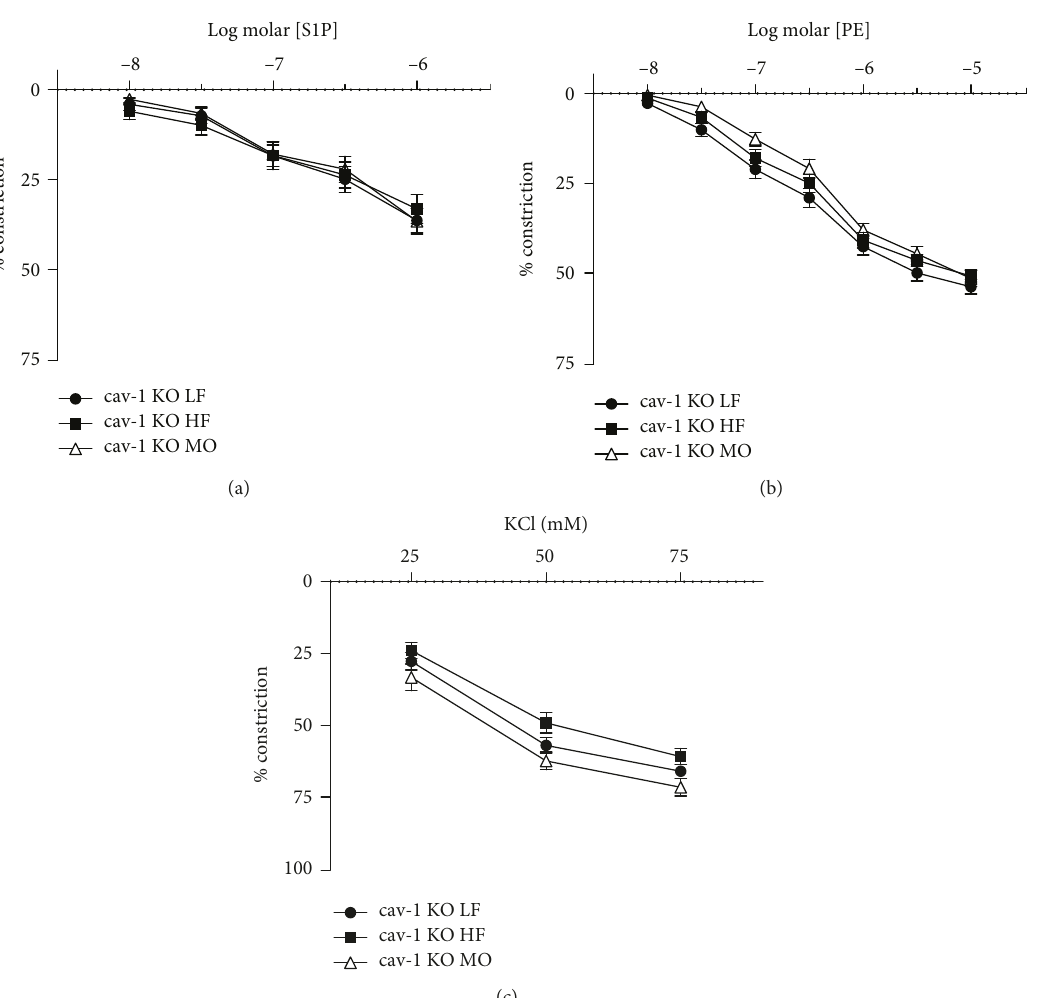
Figure 4: Constriction of gracilis arteries from cav-1 KO mice on LF, HF, and MO diets to S1P (a), PE (b), and KCl (c). Mean ± SEM , n = 12 ‐ 14 per group, ∗ p < 0 05 vs. LF. Two-way repeated-measures ANOVA followed by Sidak ’ s multiple comparison